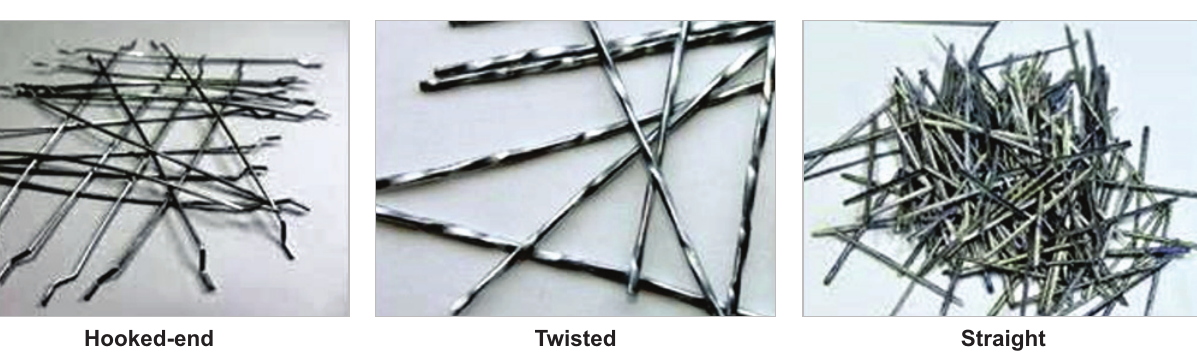
Hooked-end Polypropylene Synthetic and steel fibers used in concrete structures